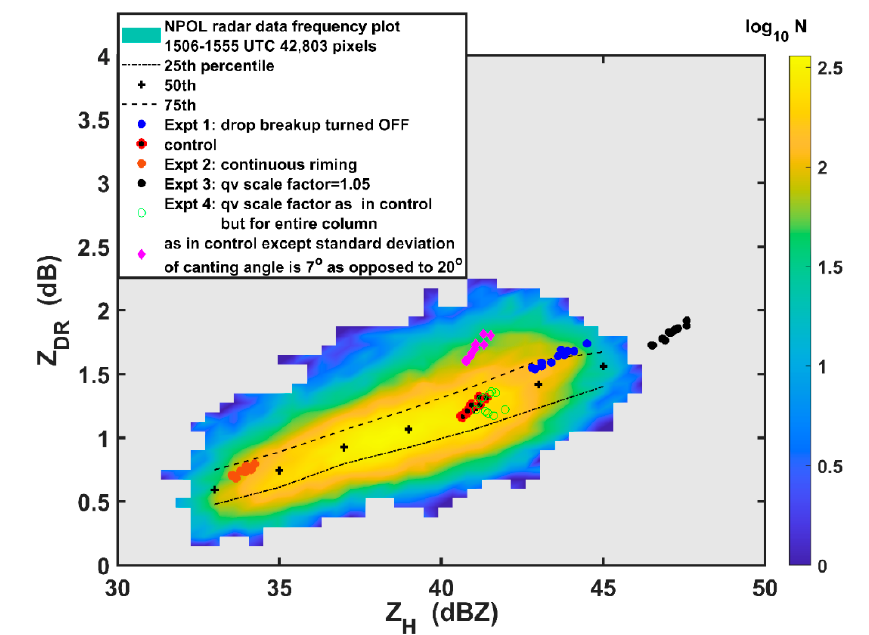
Figure 11. NPOL radar data from all the RHI scans over the instrumented site with (Z H , Z DR ) extracted from the range interval 30–50 km and height interval 0.5–2 km. The radar data are plotted as the frequency of occurrence of the pairs (Z H , Z DR ). The 25th, 50th, and 75th percentiles of Z DR for 2 ‐ dB bins of Z H are plotted as explained in the legend. The circles are from McSnow DSDs as in Figure 10.